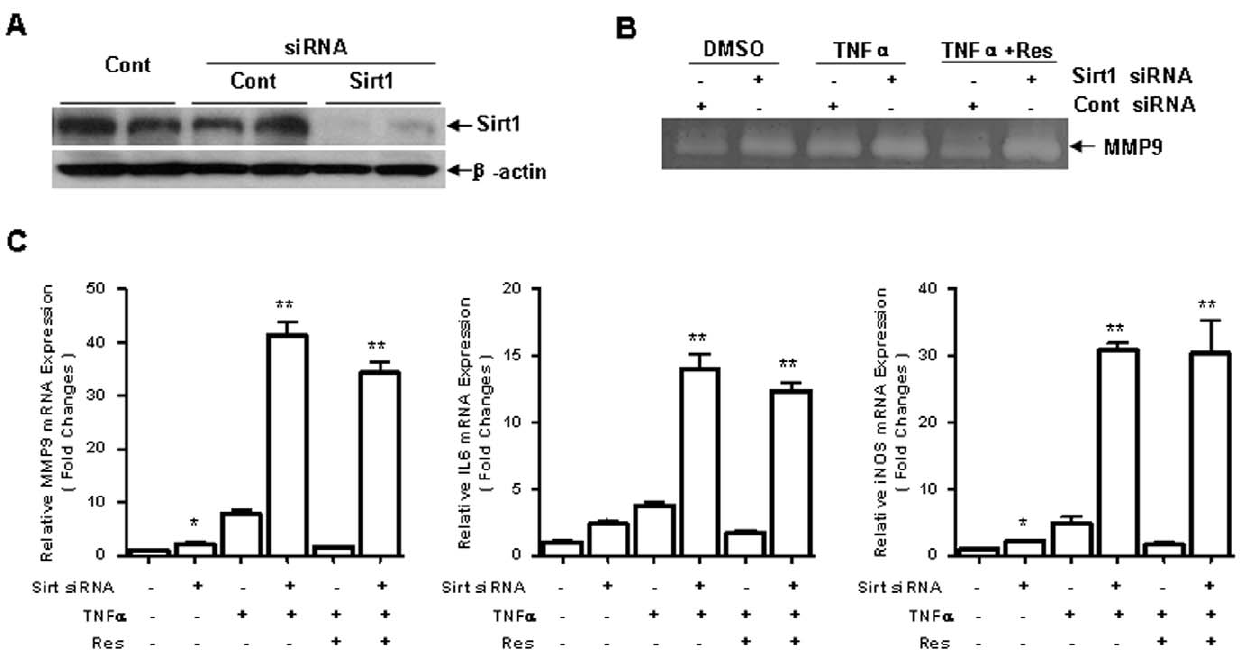
Figure 3. Resveratrol Inhibited inflammation in a Sirt1 dependent manner. A. Western blotting analysis shows Sirt1 siRNA (20 nM) transfection for 72 hours strikingly blocked Sirt1 expression, compared to control (Cont) siRNA (20 nM) or DDW transfection. B. After Sirt1 or control siRNA transfection for 72 h, cells were h pretreated with resveratrol (50 nM) in the presence of TNF- a (10 ng/ml) treatment for 24 h, MMP-9 expression in the medium were examined by gelatin zymography. C. Cells were processed as (B) for 6 h, real-time RT-PCR analysis was used to examine mRNA expression of MMP-9, IL-6, iNOS (n=3 per group, * p , 0.05 vs. Sirt1 siRNA-; ** p , 0.01 vs. Sirt1 siRNA-).